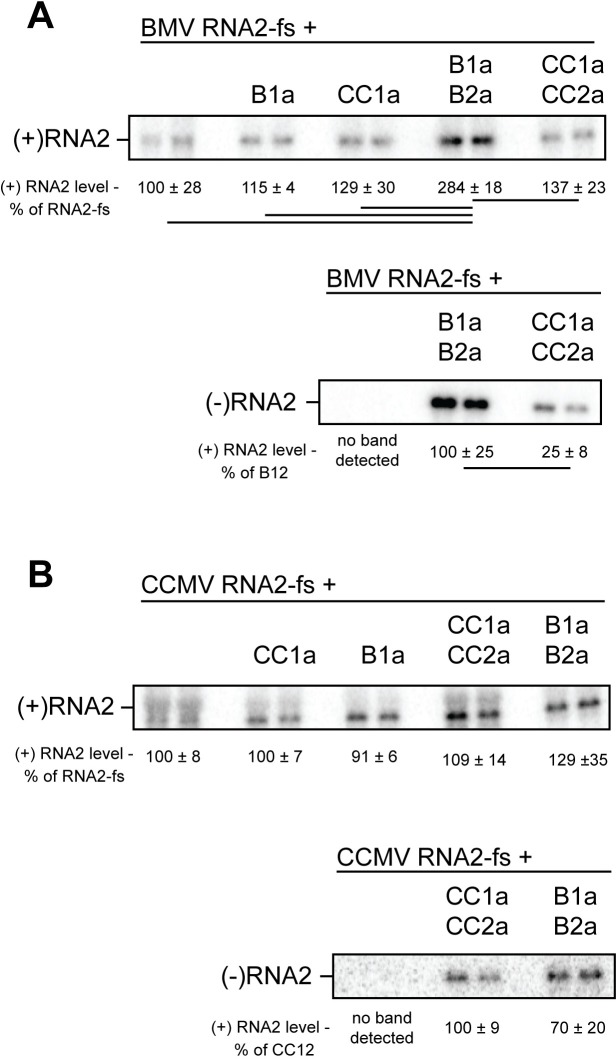
1a-dependent RNA accumulation and replication of bromovirus RNA2 templates in yeast.(A) Northern blot from total RNA from yeast expressing BMV RNA2 alone or with BMV 1a and/or 2a or CCMV 1a and/or 2a as indicated. Relative levels of RNA2 are indicated beneath the blots. (B) As in (A) except with a CCMV RNA2 template in place of BMV RNA3. The average and standard deviation of three replicates is shown beneath the lanes. A line connecting two numbers indicates a statistically significant difference (p<0.05).